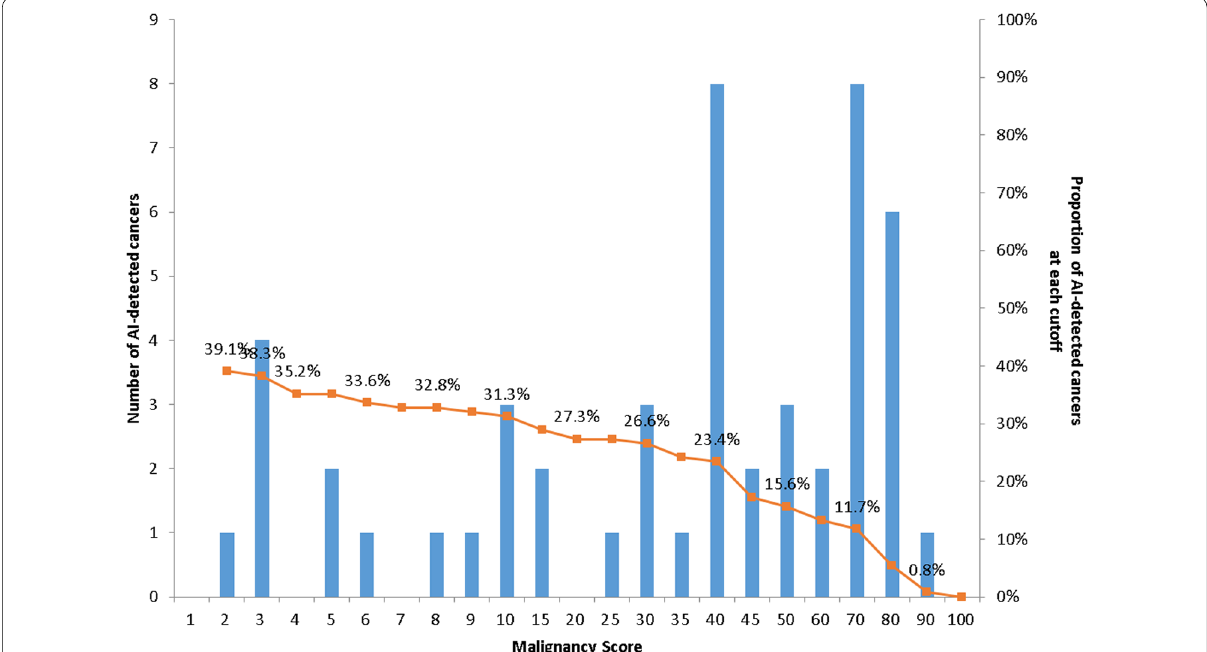
Fig. 2 Proportion of AI-detected cancers according to different cutoffs. The proportions of AI-detected cancers among the 128 mammographically occult breast cancers at different cutoffs are shown as a line graph, with histograms displaying the distribution of malignancy